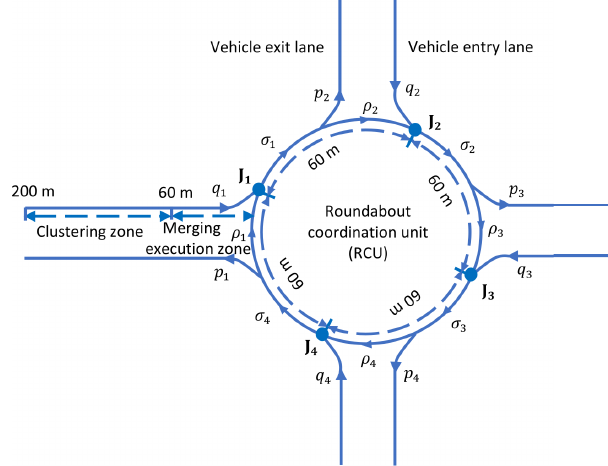
Figure 2. Traffic flow diagram (TFD) of a single-lane four-legged